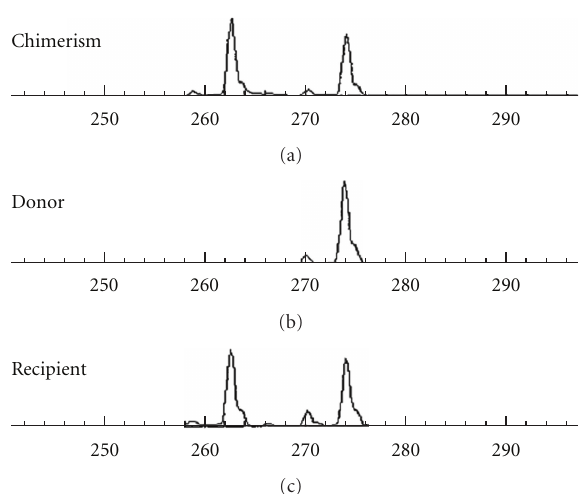
Figure 4: STR (short tandem repeat) analysis of the lymphoma